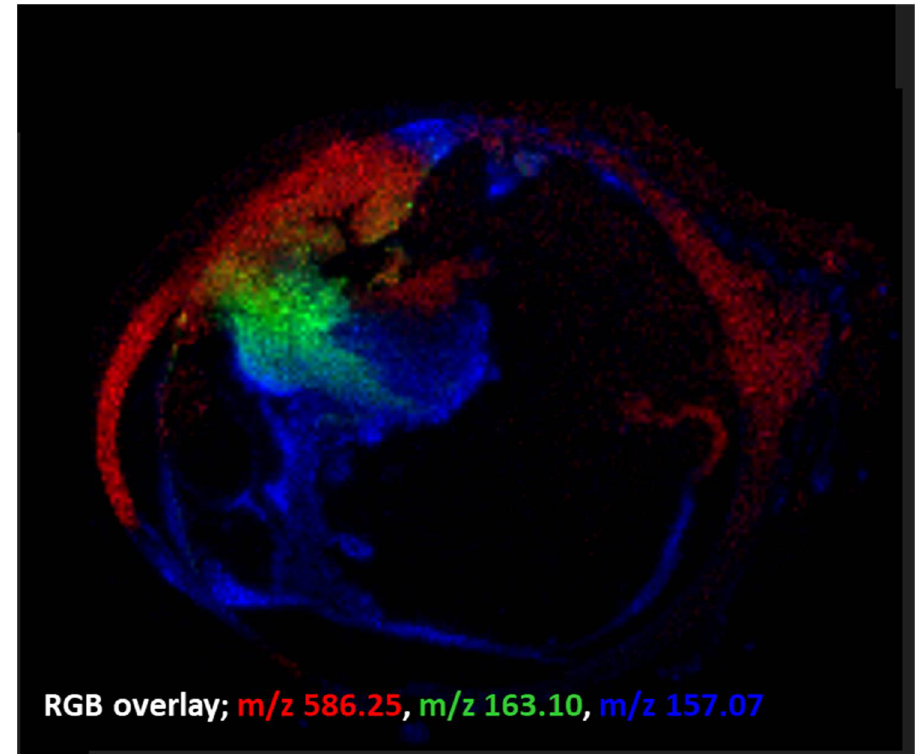
Figure 2. MALDI-MSI ion overlay data from an FFPE human eye section (merged from Figure 1 ion images). These data indicate that even after the many wash steps in FFPE removal and a standard antigen retrieval procedure, important low molecular weight species in tumour progression (e.g., m/z 586.2, [M + K] + , LPC 20:2) are still observable in MALDI-MSI. Images indicate distinct intratumoural heterogeneity.